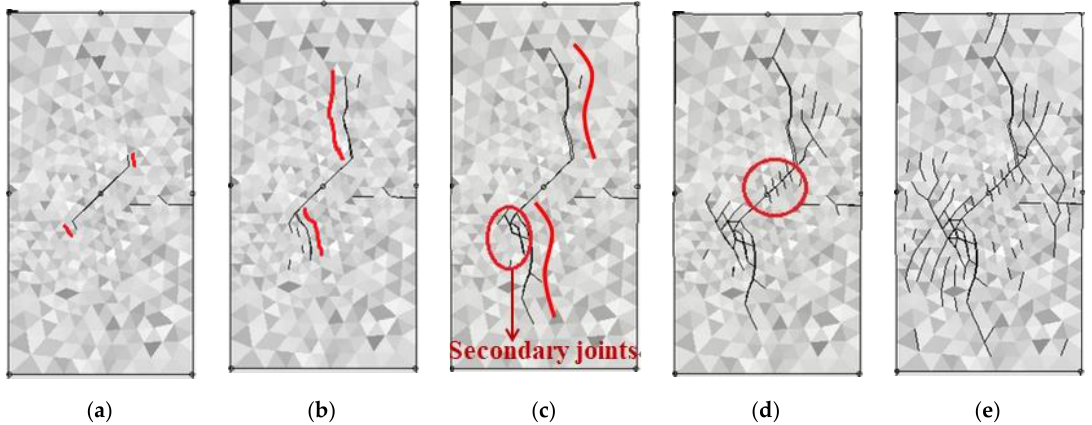
Figure 11. Failure process of Case 2 in uniaxial compression simulation experiment. ( a ) The ends of the preset joints cracked and wing cracks appeared; ( b ) Wing cracks expanded; ( c ) The width of the wing crack increased and fine cracks and some secondary joints appeared; ( d ) A group of new oblique parallel cracks appeared; ( e ) The fine cracks became connected with the wing cracks and preset joints .